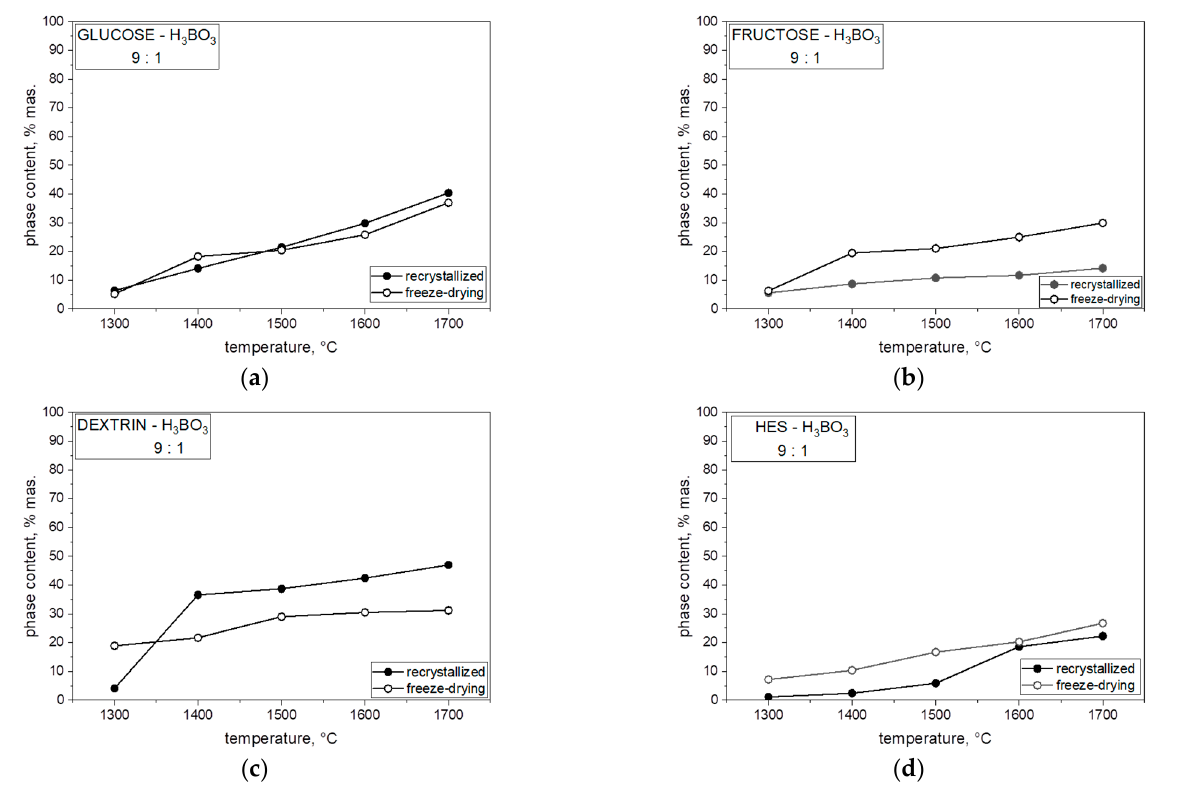
Figure 8. Temperature dependences of boron carbide content in the prepared powders from recrystallization and freeze-drying: ( a ) glucose, ( b ) fructose, ( c ) dextrin, and ( d ) HES.